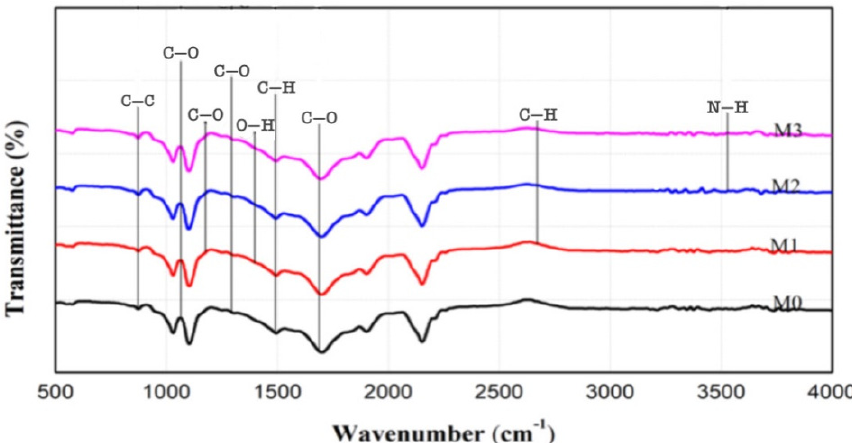
Figure 4. IR spectra of the original PVDF and the modified PVDF with Pol, S-CnT, and M-CnT. The measurement of FTIR was done using a dry membrane at room